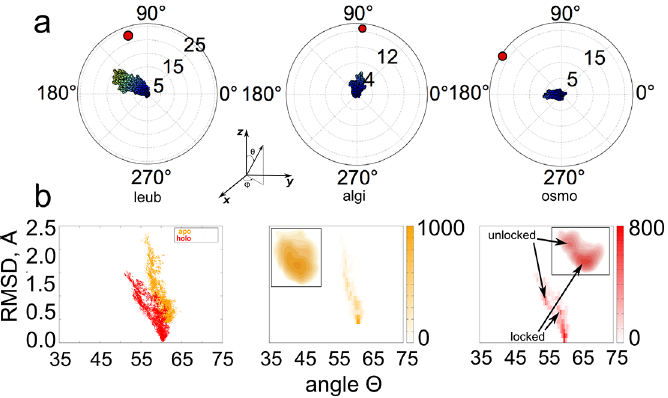
Fig 3. Sampling trajectories on the constraint manifold encode collective motions. a) KGS conformational distributions starting from three ligand-free holo crystal structures (leub, algi, osmo) are biased toward the apo structures. The polar plots show the distribution of the angles θ (along the radius), and ϕ (along the circumference) of the center of mass of domain two with respect to domain one (see Methods). The domains open, reorient, and deform upon adopting the apo conformation (red circle), affecting the relative position of the centers of mass of the domains. The orientation of domain two starts out at the origin. The colors of samples are red-shifted toward higher sampling number. The conformations diffuse toward the apo state as sampling progresses. b) The KGS conformational distribution along the reaction coordinates θ and RMSD (in Å ) to the holo crystal structure of apo and holo human lysozyme. The holo distribution samples more broadly, and more towards smaller θ angles than the apo distribution, in agreement with the free-energy landscape observed from RDC restrained simulations (left panel). The middle and right panel show the sampling distribution for apo and holo in more detail. (Inset: free-energy landscapes from RDC restrained MD simulations. Images adapted from [29]). Weak local maxima approximately corresponding to the ‘ unlocked ’ and ‘ locked ’ state can be observed in the distribution starting from the holo